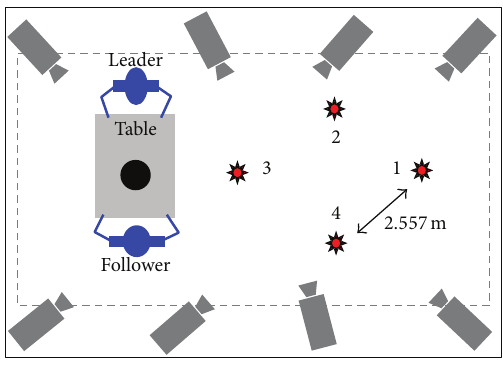
Figure 1: An overhead view of Experiment 1. The stars represent red targets projected on the floor via ceiling mounted laser